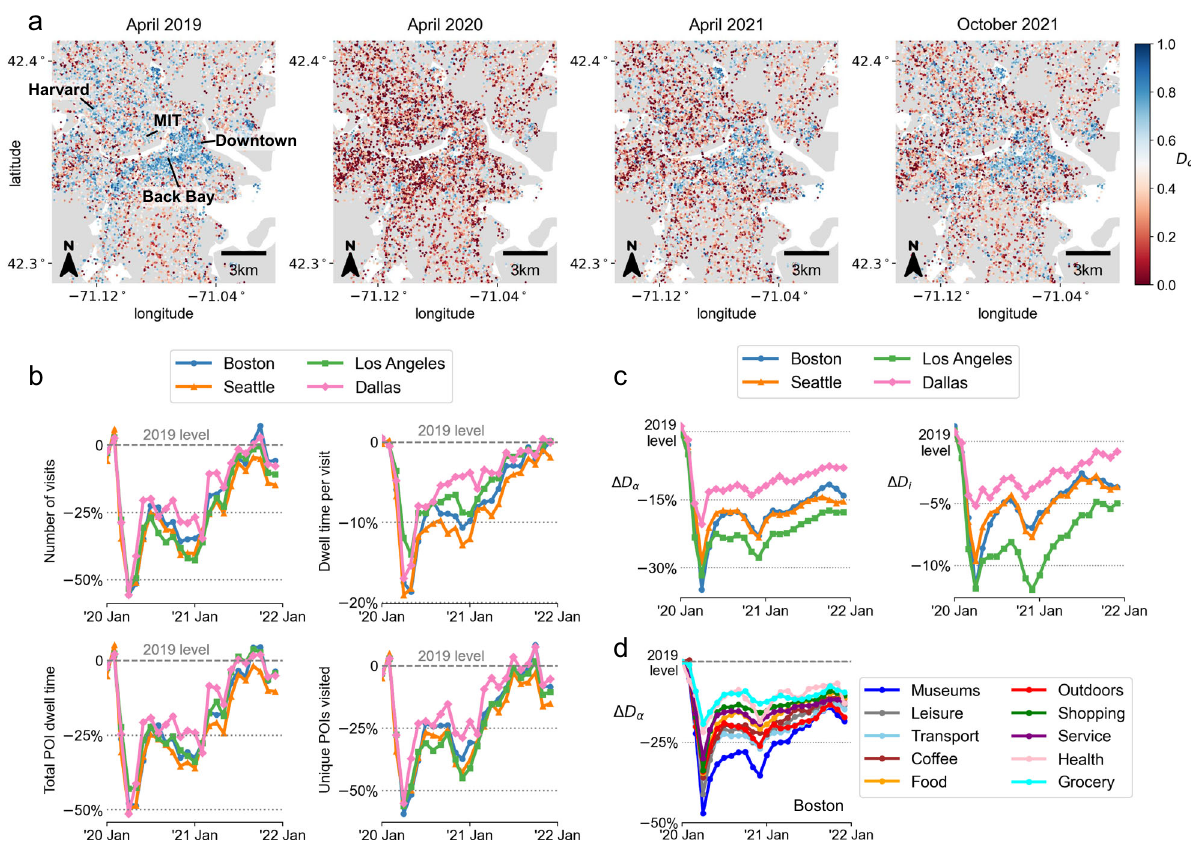
Fig. 1 | Diversity of urban encounters has decreased during COVID-19. a Map shows that the income diversity of encounters in places in the Boston and Cam- bridge area decreased during the pandemic. Diversity gradually recovers with reopening,albeitnotfullycomparedtopre-pandemiclevels,eveninOctober2021. b Aggregatemobilitymetrics,suchasthedailynumberofvisitsperindividual,daily amount of timespent at POIs, and number ofvisited unique POIs have allreturned back to pre-pandemic levels (i.e., 2019 average values) by late 2021. c Despite the recovery in mobility statistics, the diversity of encounters experienced at places and by individuals has decreased and have not recovered back to pre-pandemic